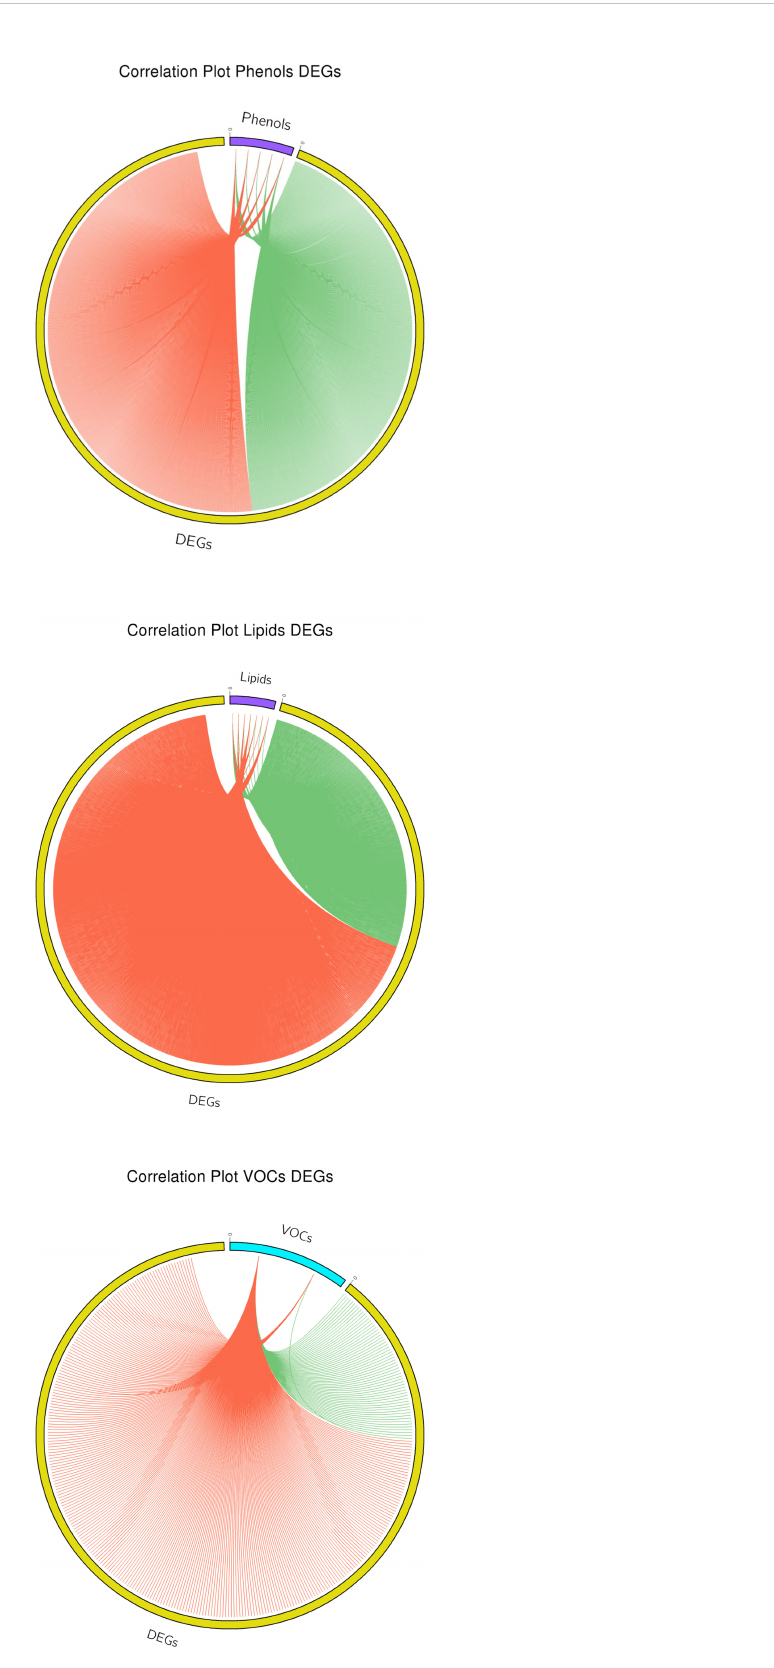
FIGURE 8 Interactome based correlation between DEGs and phenolic compounds (A) , lipids (B) and two volatiles, acetaldehyde and ethanol (C) . For each plot, positive and negative correlation are highlighted with red and green color,